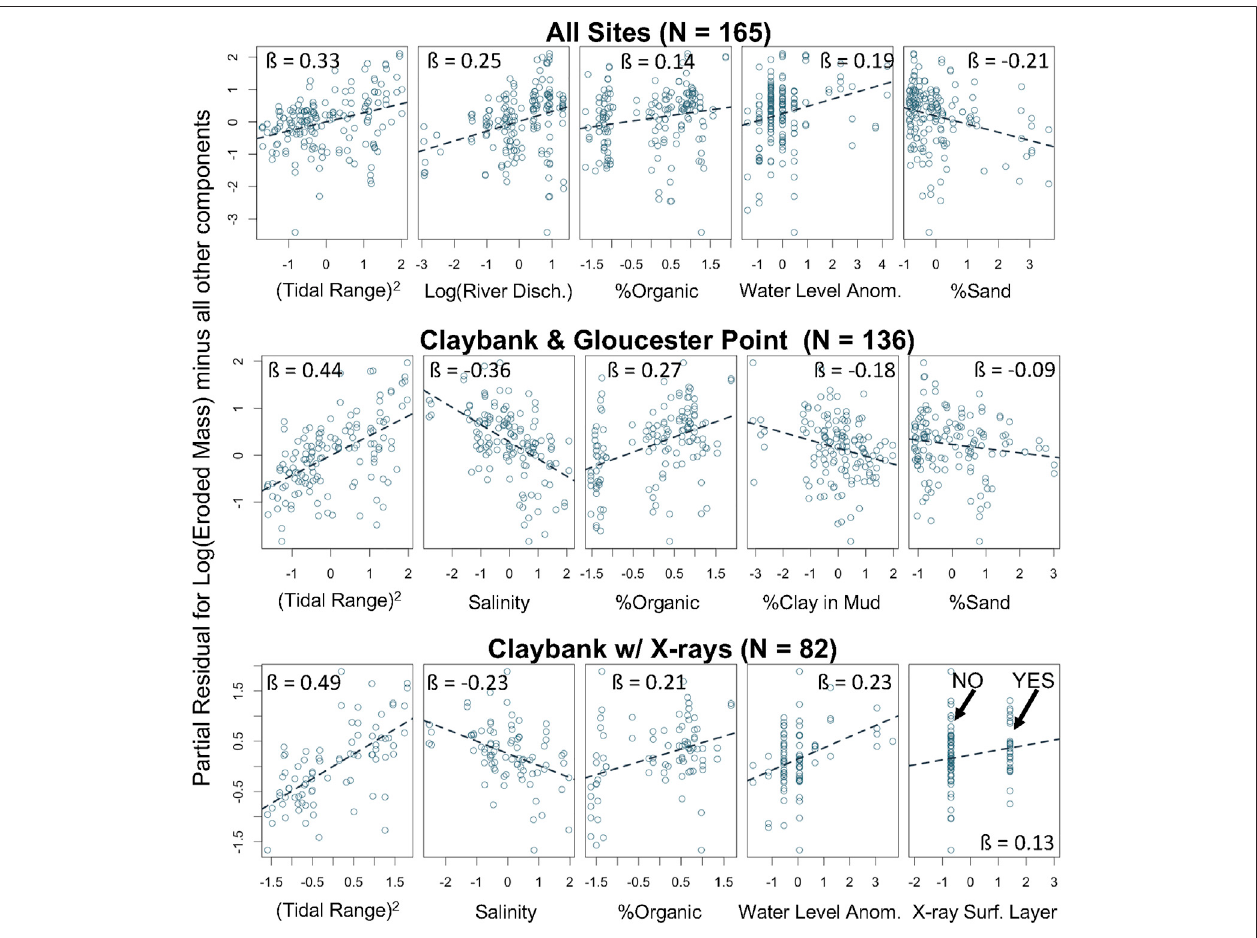
FIGURE 8 | Partial residual plots from the Eroded Mass Model Set for three representative, 5-component models from three data subsets. Each plot has standardized units for X q and for β q X q + ε on the x - and y -axis, respectively. Trend lines each have a slope equal to the parameter ’ s β value.